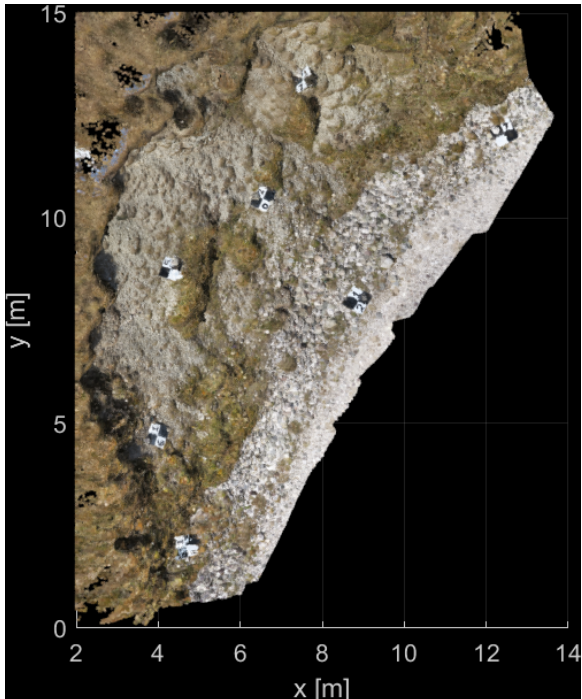
Figure 3. Top view of the area reconstructed via close-range photogrammetry.